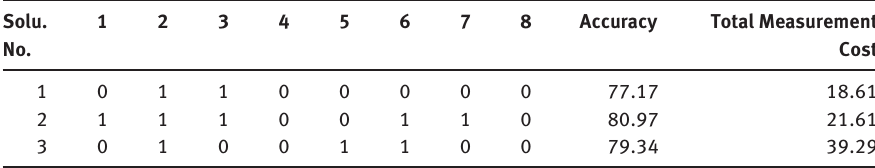
“1” indicates the presence of feature and “0” indicates its absence.